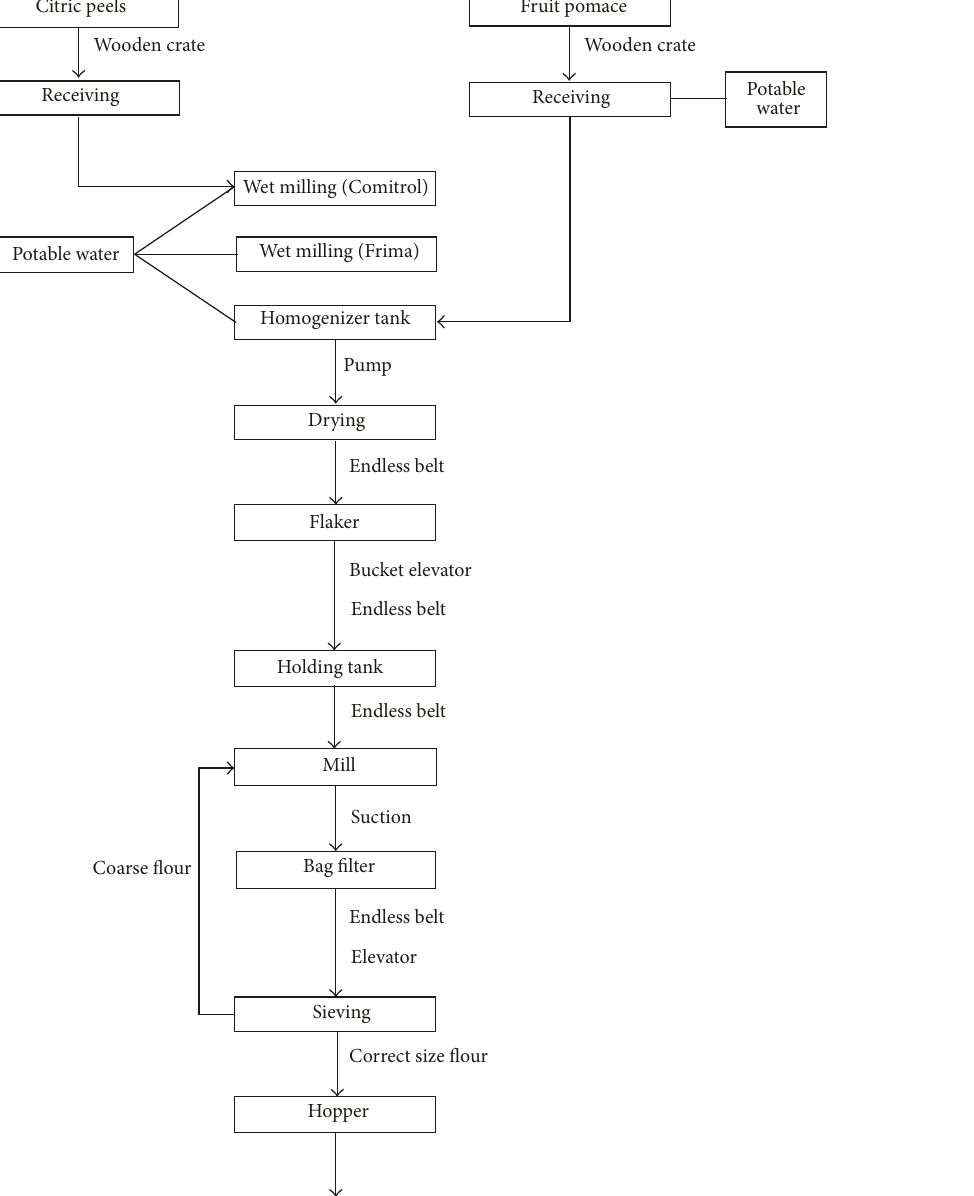
production line. Volatiles were identified through their